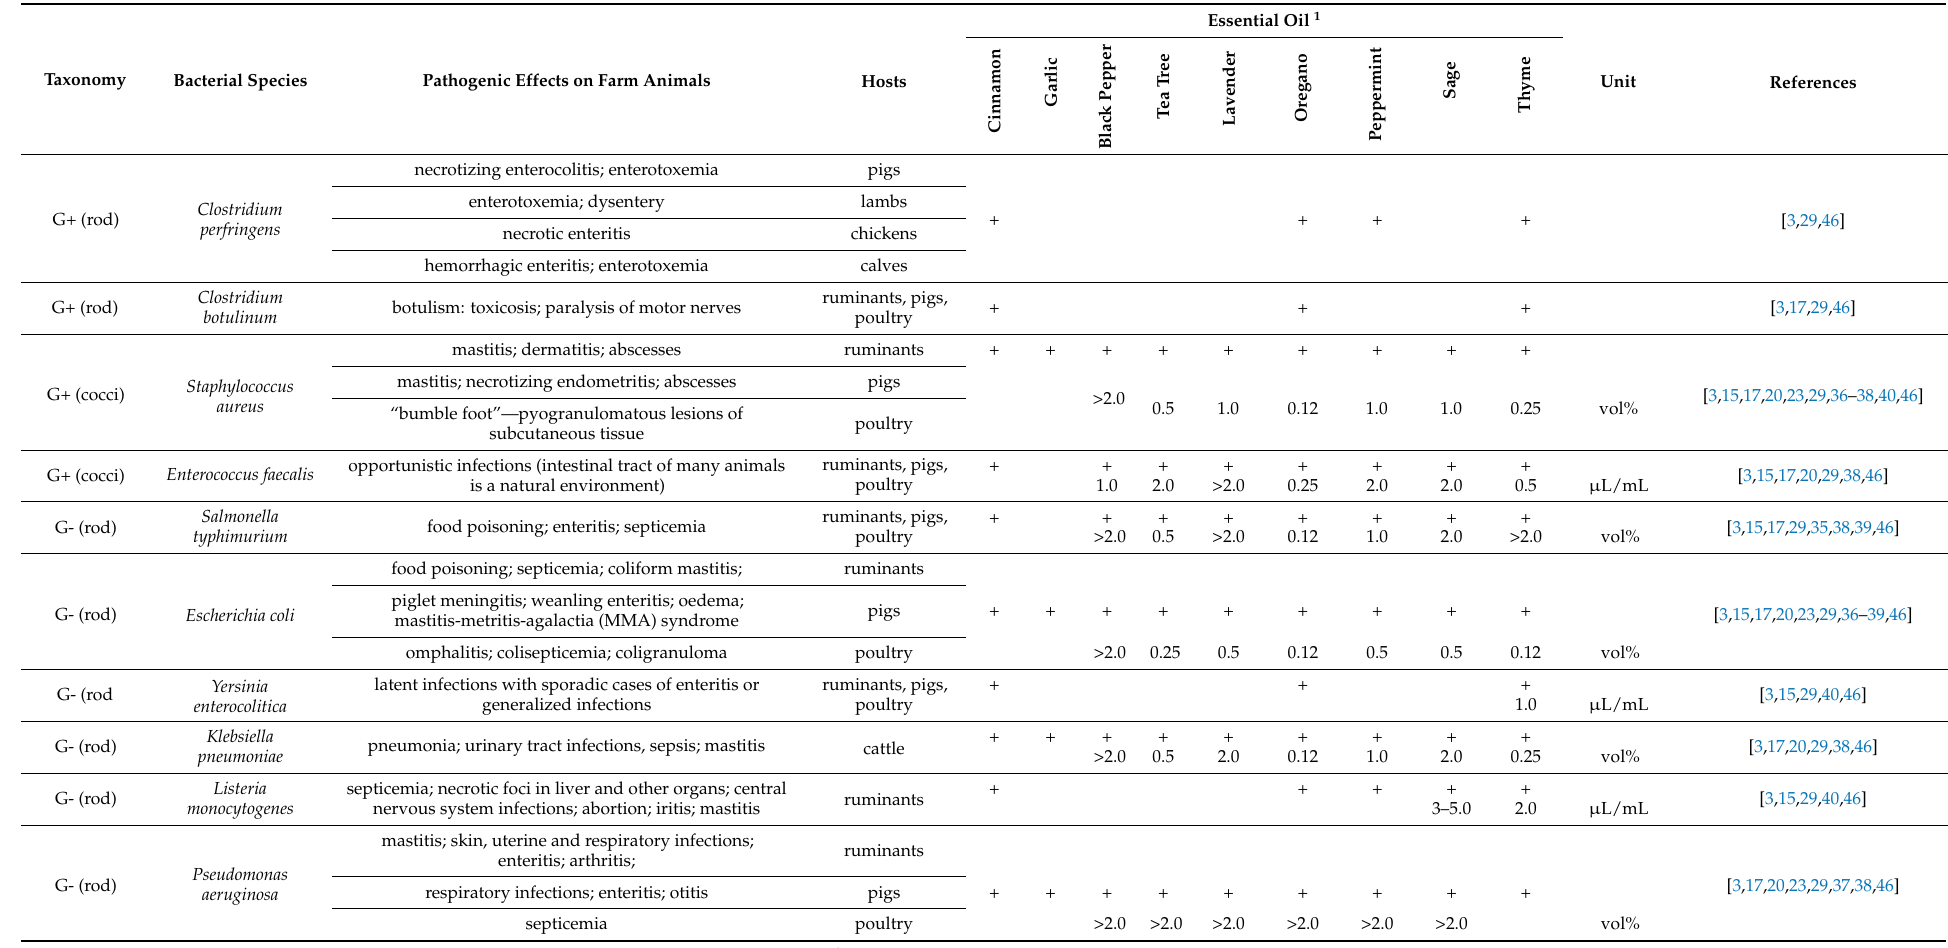
Table 2. Antibacterial properties of selected essential oils (EOs) and sensitivity of animal pathogenic bacteria to essential oils (minimum inhibitory